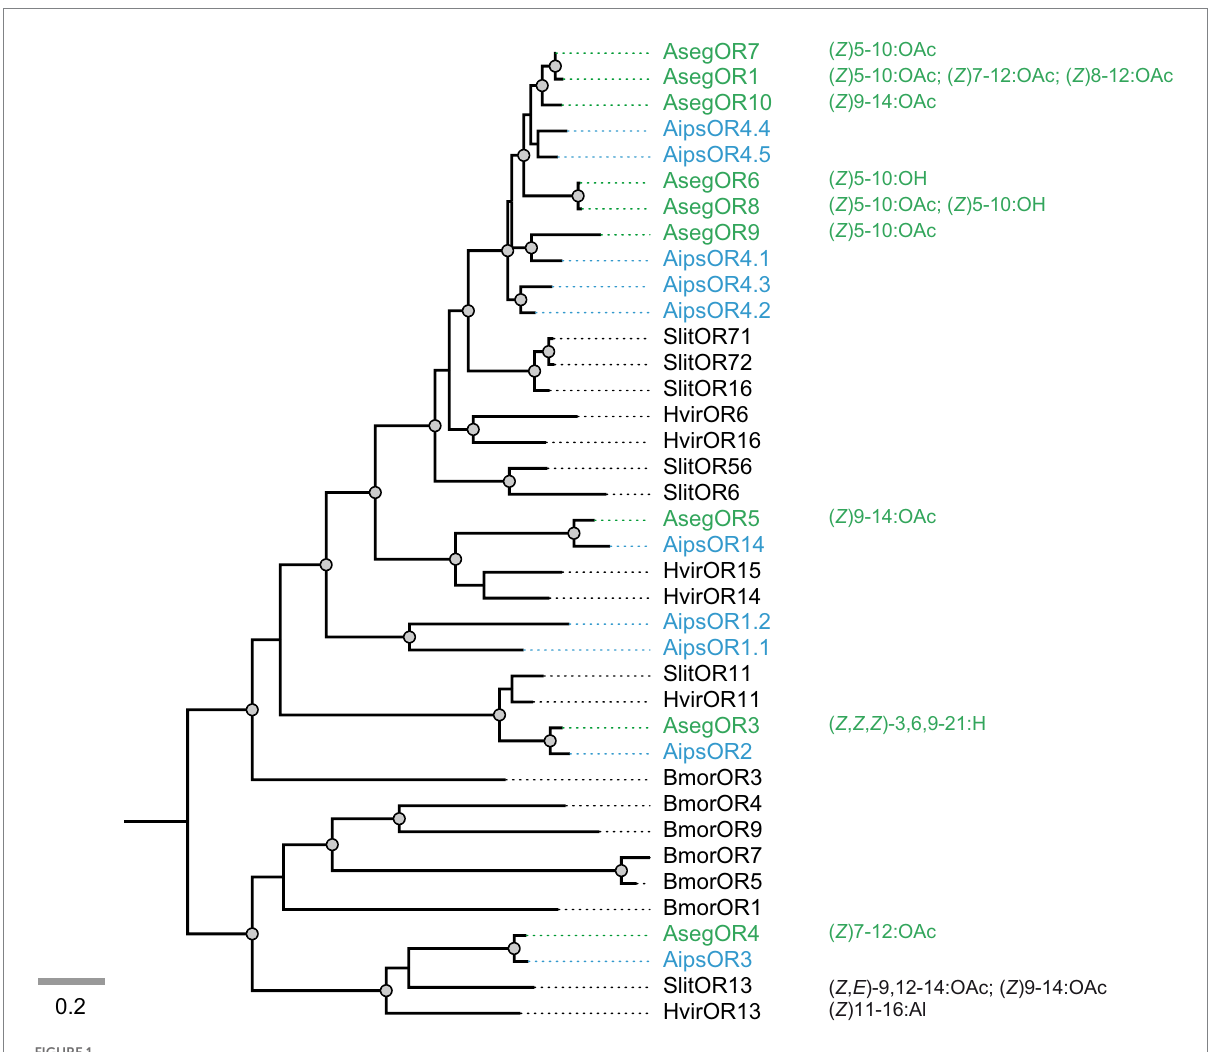
FIGURE 1 Phylogenetic position of Agrotis ipsilon ORs within the moth sex pheromone receptor clade. The maximum-likelihood tree was built from the alignment of amino acid sequences from A. ipsilon (Aips, in blue), A. segetum (Aseg, in green), Bombyx mori (Bmor), Heliothis virescens (Hvir) and Spodoptera littoralis (Slit). Nodes supported by the likelihood-ratio test (aLRT > 0.9) are shown with gray dots. The best ligands of AsegORs identified previously (Zhang and Löfstedt, 2013; Zhang et al., 2016) are indicated, as well as those of the AipsOR3 orthologues HvirOR13 and SlitOR13 (Große-Wilde et al., 2007; de Fouchier et al.,